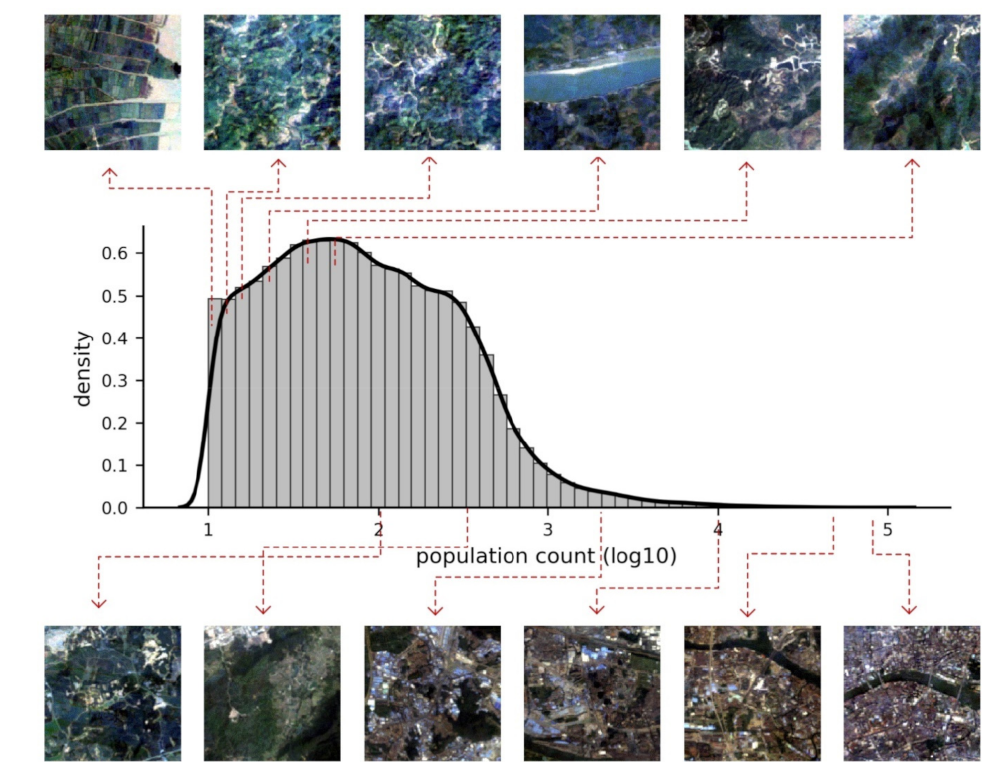
Figure 5. Probability density distribution of population count in the ground-truth samples and example RS image patches that correspond to various population